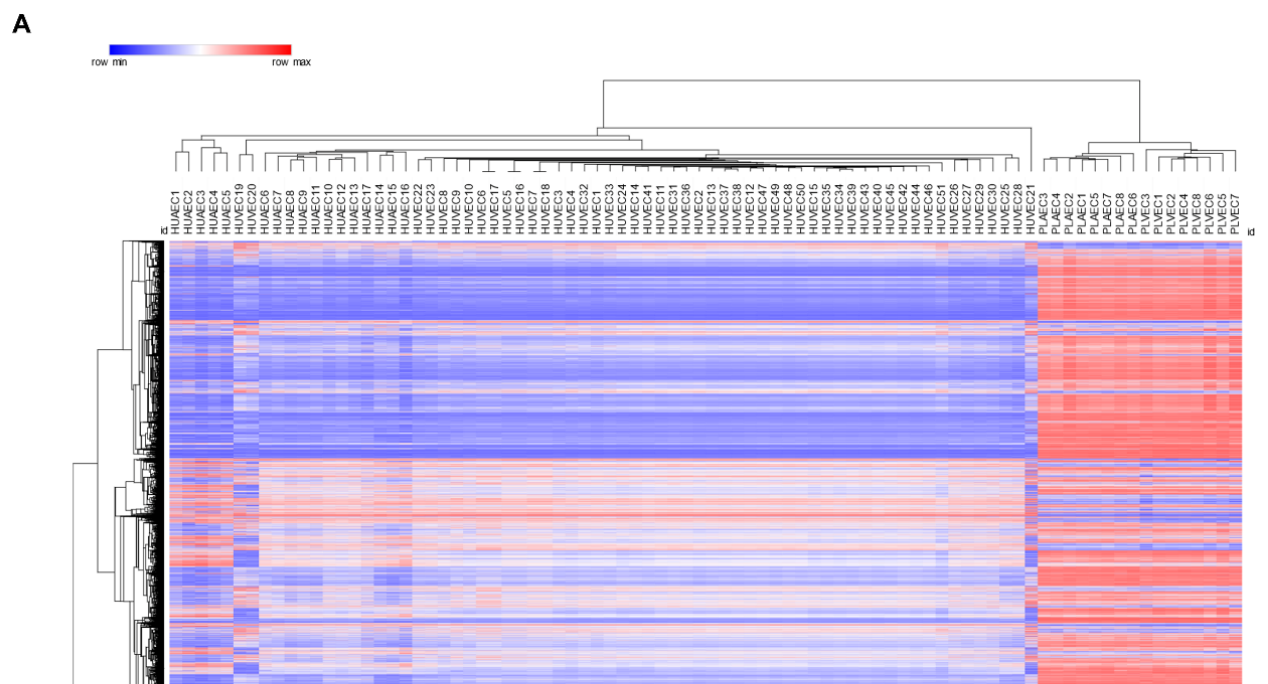
Figure 1. Transcriptional profiling, grouping, and proximity of umbilical and placental endothelial cells. ( A ) Hierarchical analysis of 17,280 transcripts commonly expressed in endothelial cells of the umbilical-placental bed. MDS ( B ), t-SNE ( C ), and PHATE ( D ) plots showing dissimilarities, similar- ities, and relative proximity among HUAEC (red dots), HUVEC (blue dots), PLAEC (light red dots), and PLVEC (light blue dots).